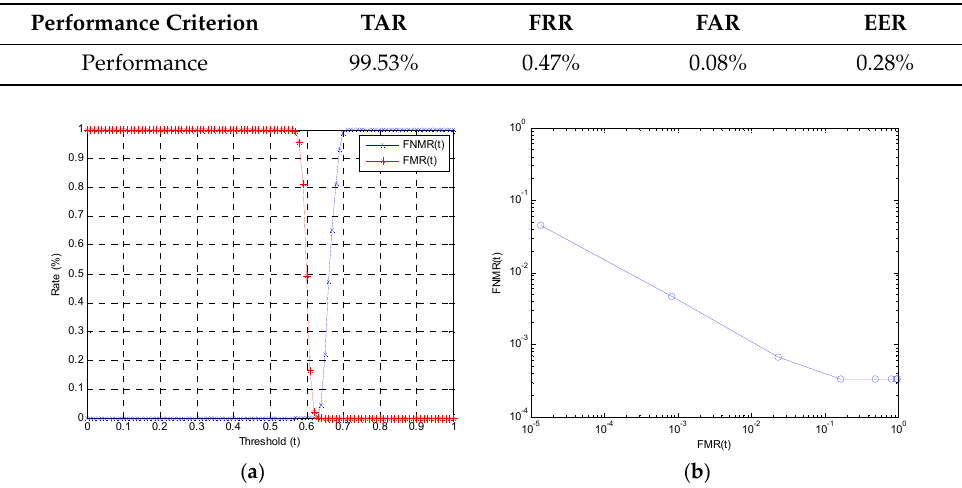
Figure 12. Cumulative accuracies of face recognition on the E-face database ( a ) and XM2VTS face Table 2. Performance evaluation of the proposed face recognition approach on the sampled PF07 database ( b ). database containing sixteen di ff erent illuminations using the following criteria: TAR—true acceptance